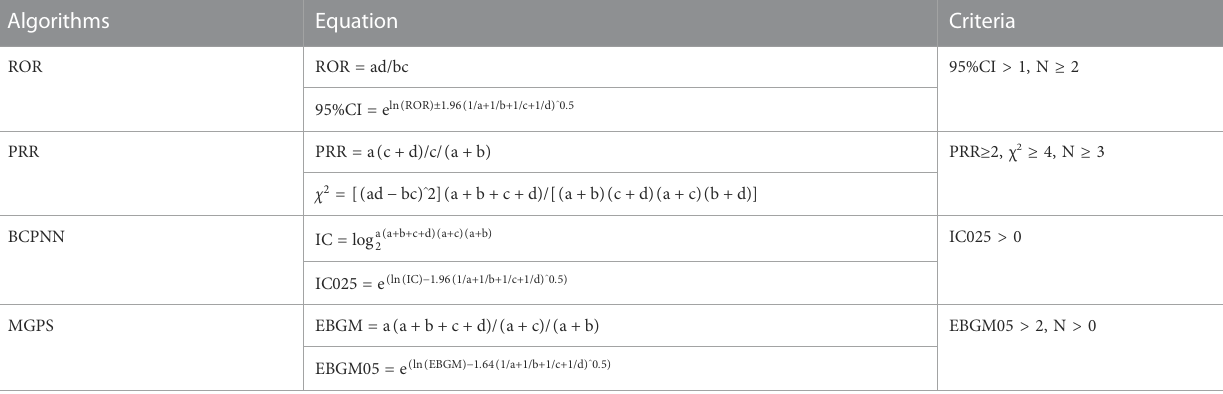
TABLE 1 Summary of major algorithms used for signal detection.